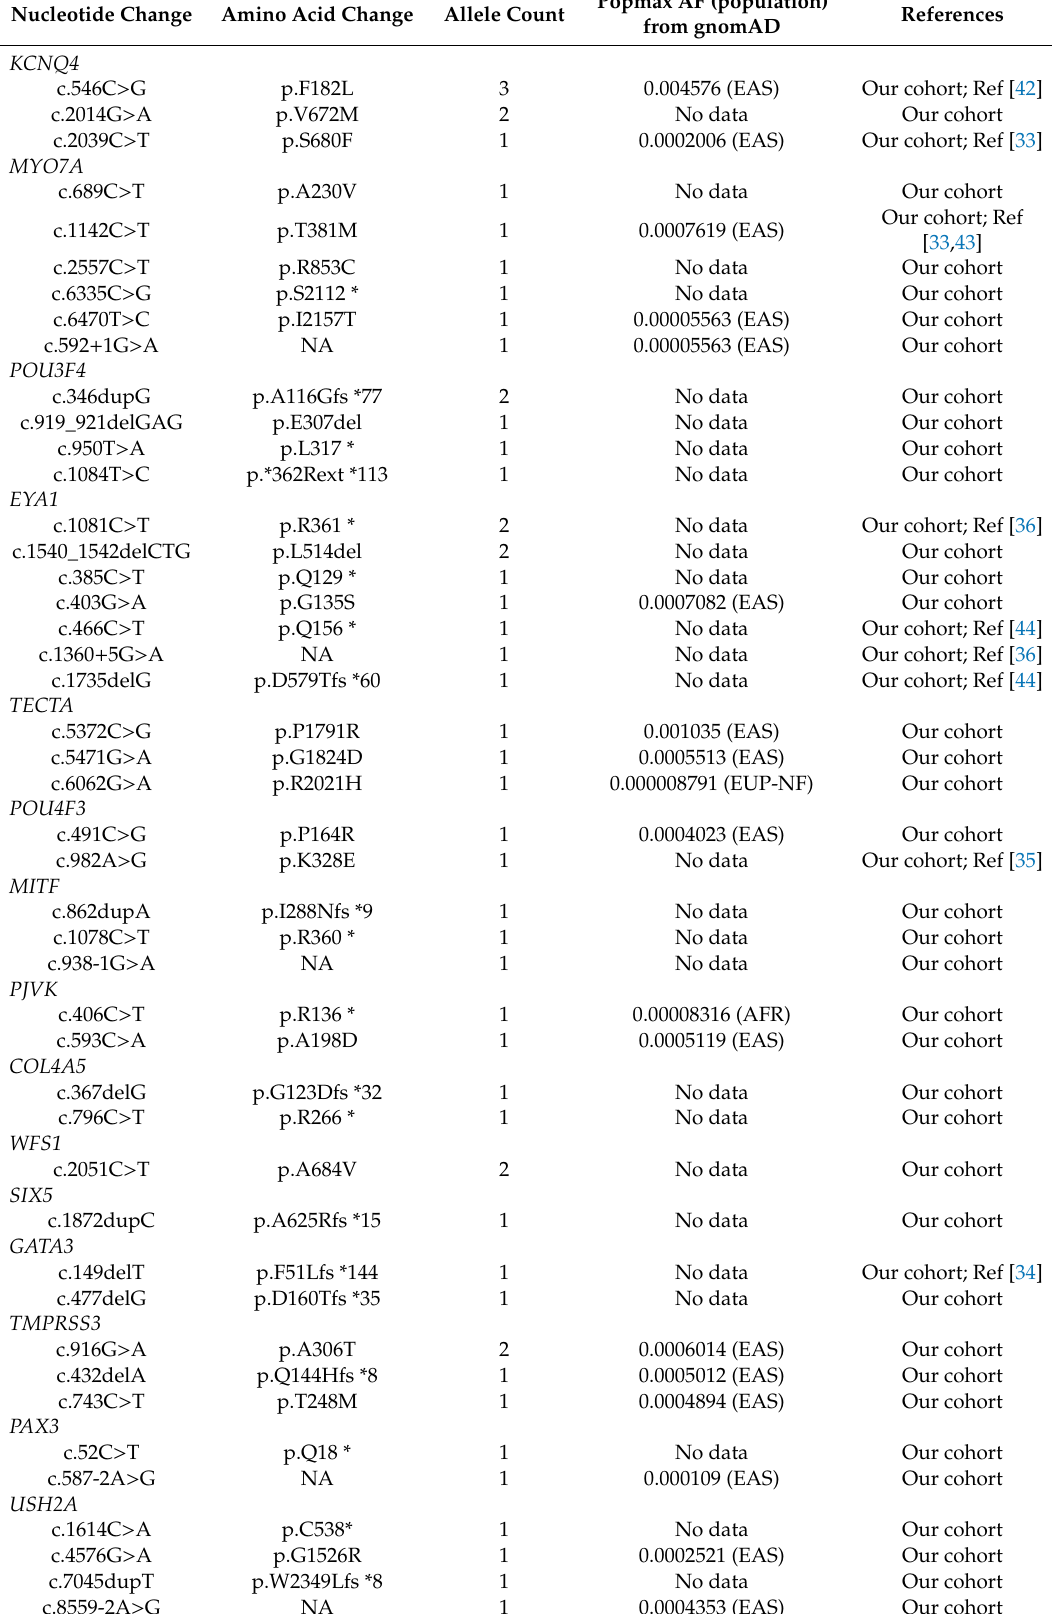
Table 6. Mutations of other deafness genes detected in Taiwanese